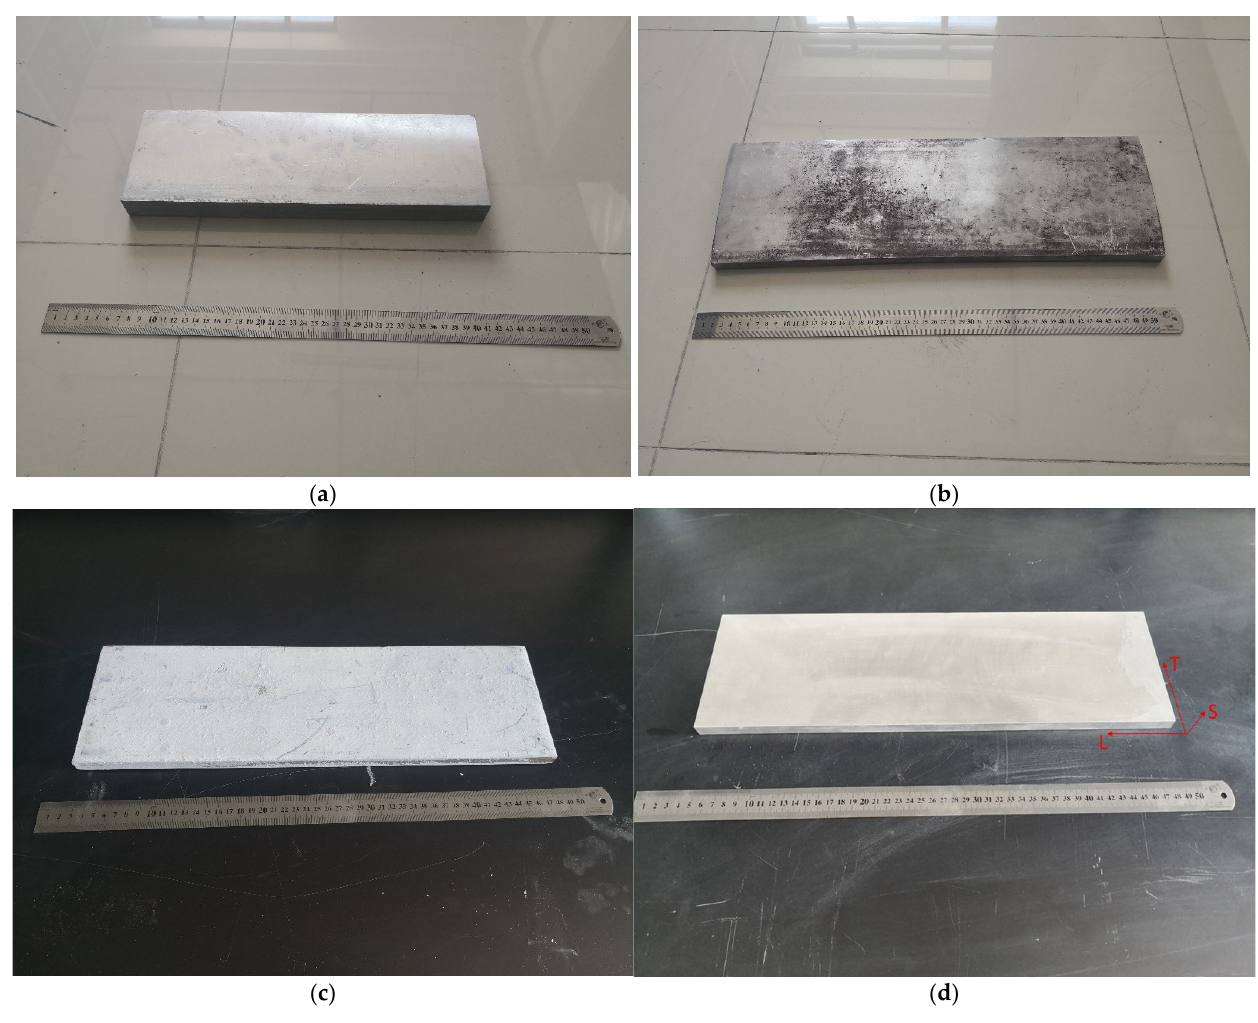
Figure 8. Preparation process for an antifriction bearing bush blank produced using a semi-continuous cast AlSn20Cu alloy: ( a ) first hot rolling, ( b ) second hot rolling, ( c ) annealing, and ( d ) final milled sheet after cold rolling.